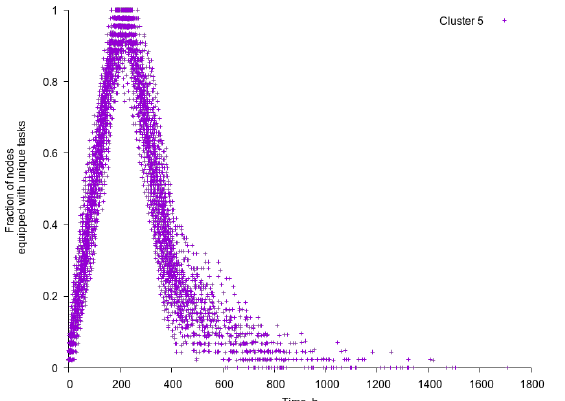
Figure 4: A fraction of nodes η TL ( t ) equipped with unique tasks for default BOINC policy for the 5-th cluster with T = 168h and d = 336h.